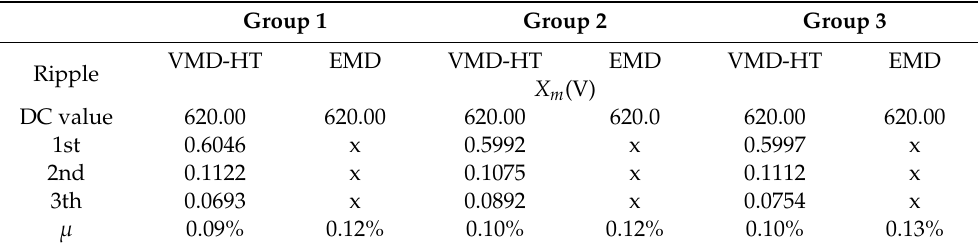
Table 6. Ripple components comparison among two methods.